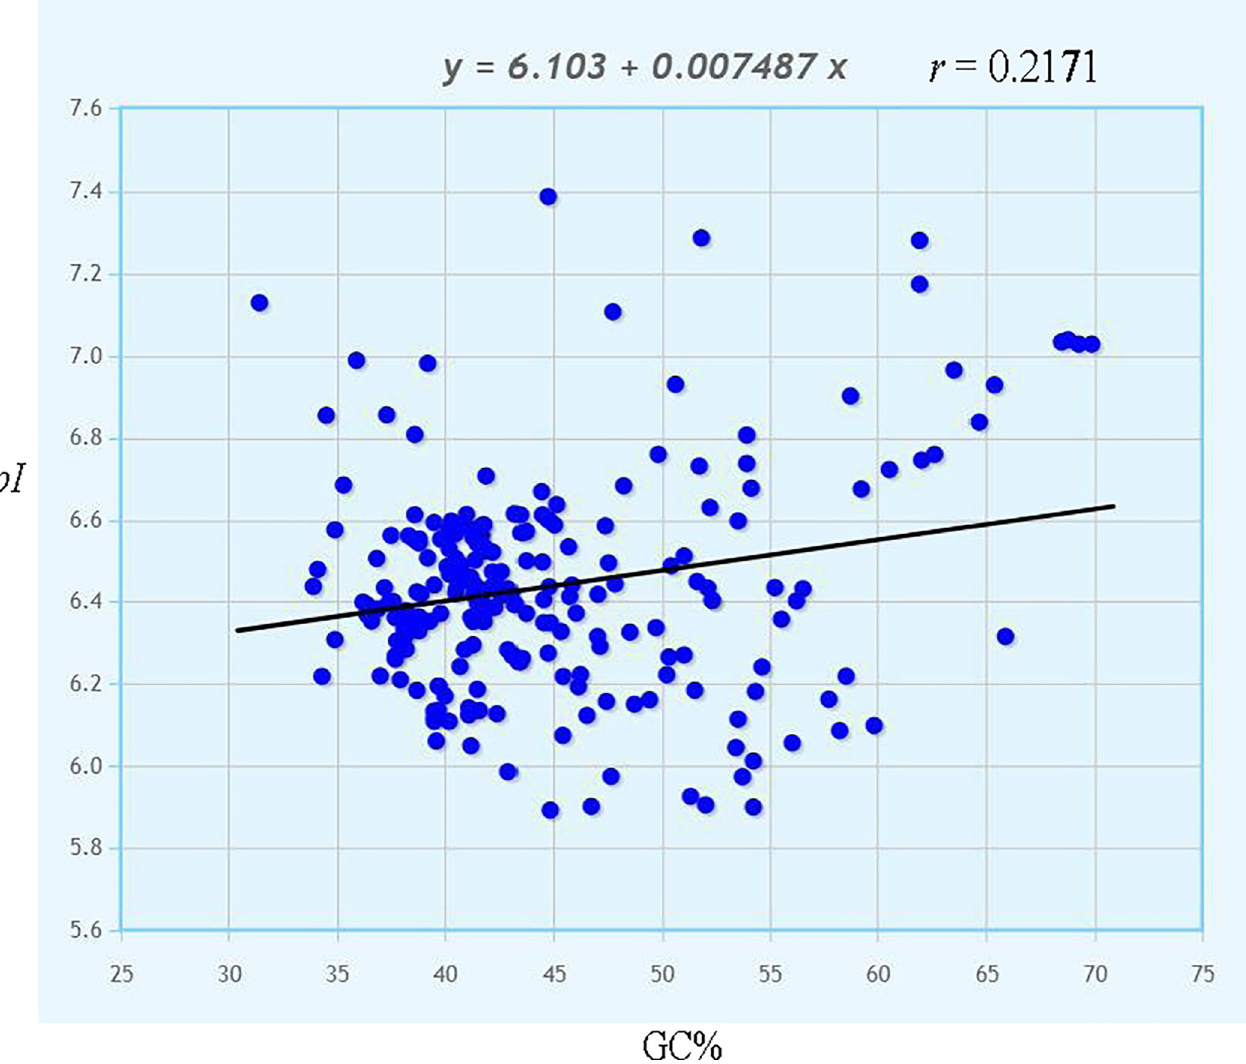
Fig 2. Correlation analysis of GC% with pI of cyanobacterial proteome. GC% show positive correlation r = 0.2172 with pI . However, the correlation coefficient was not so significant. The photographs was generated using mathportal server https://www.mathportal.org/calculators/statistics-calculator/